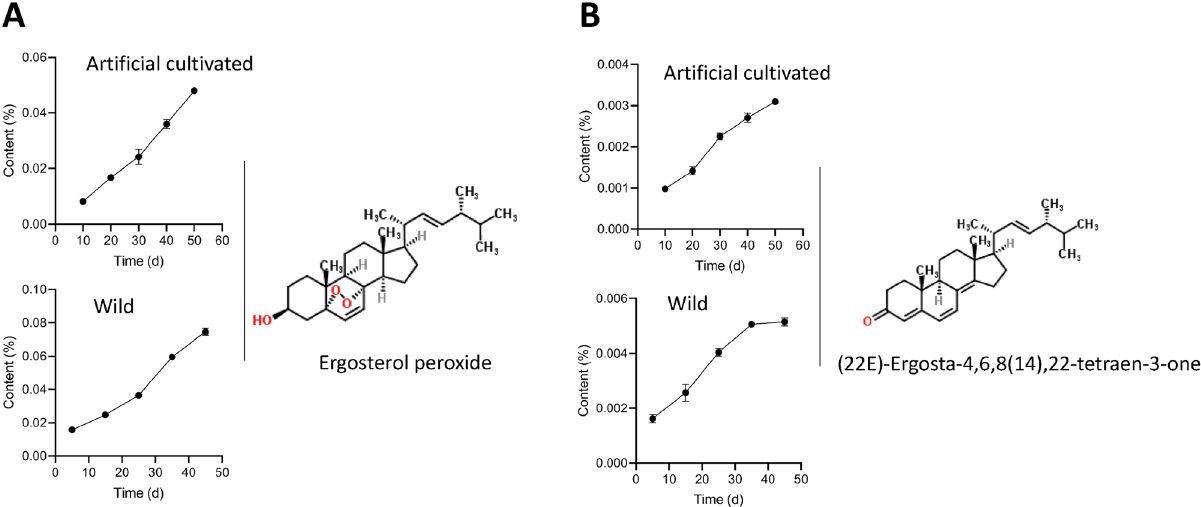
Figure 6. Contents of ergosterol peroxide and (22E)-ergosta-4,6,8(14),22-tetraen-3-one in fruiting bodies of Inonotus hispidus in different growth periods. ( A ) Ergosterol peroxide, ( B ) (22E)-ergosta-4,6,8(14),22-tetraen-3-